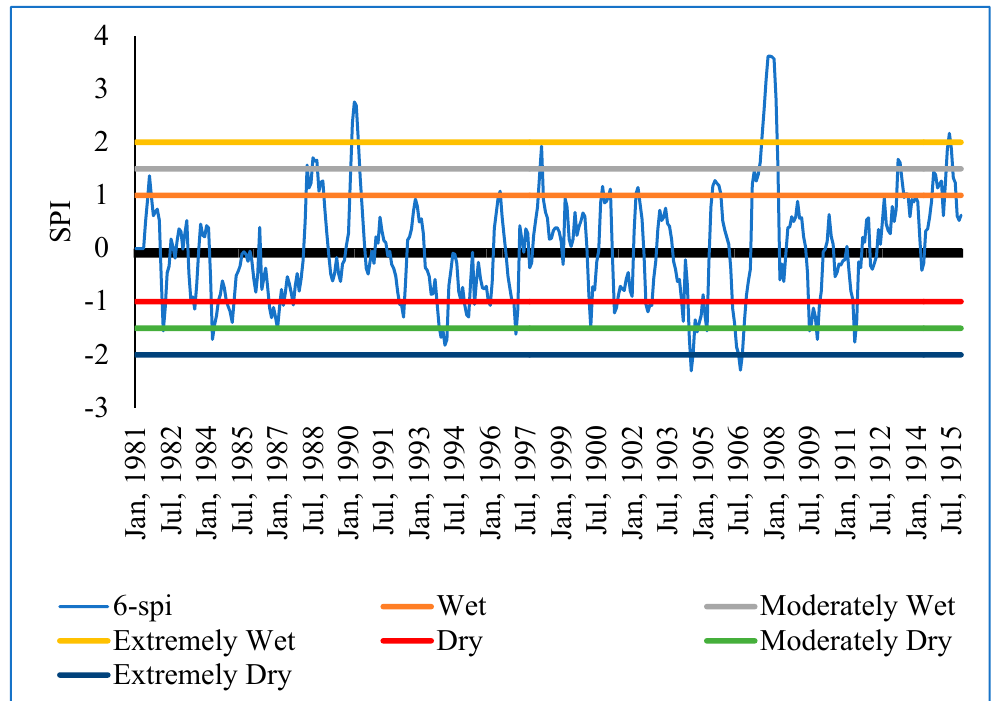
Figure 6. Six-month SPI over Sipi sub-catchment (1981–2015).